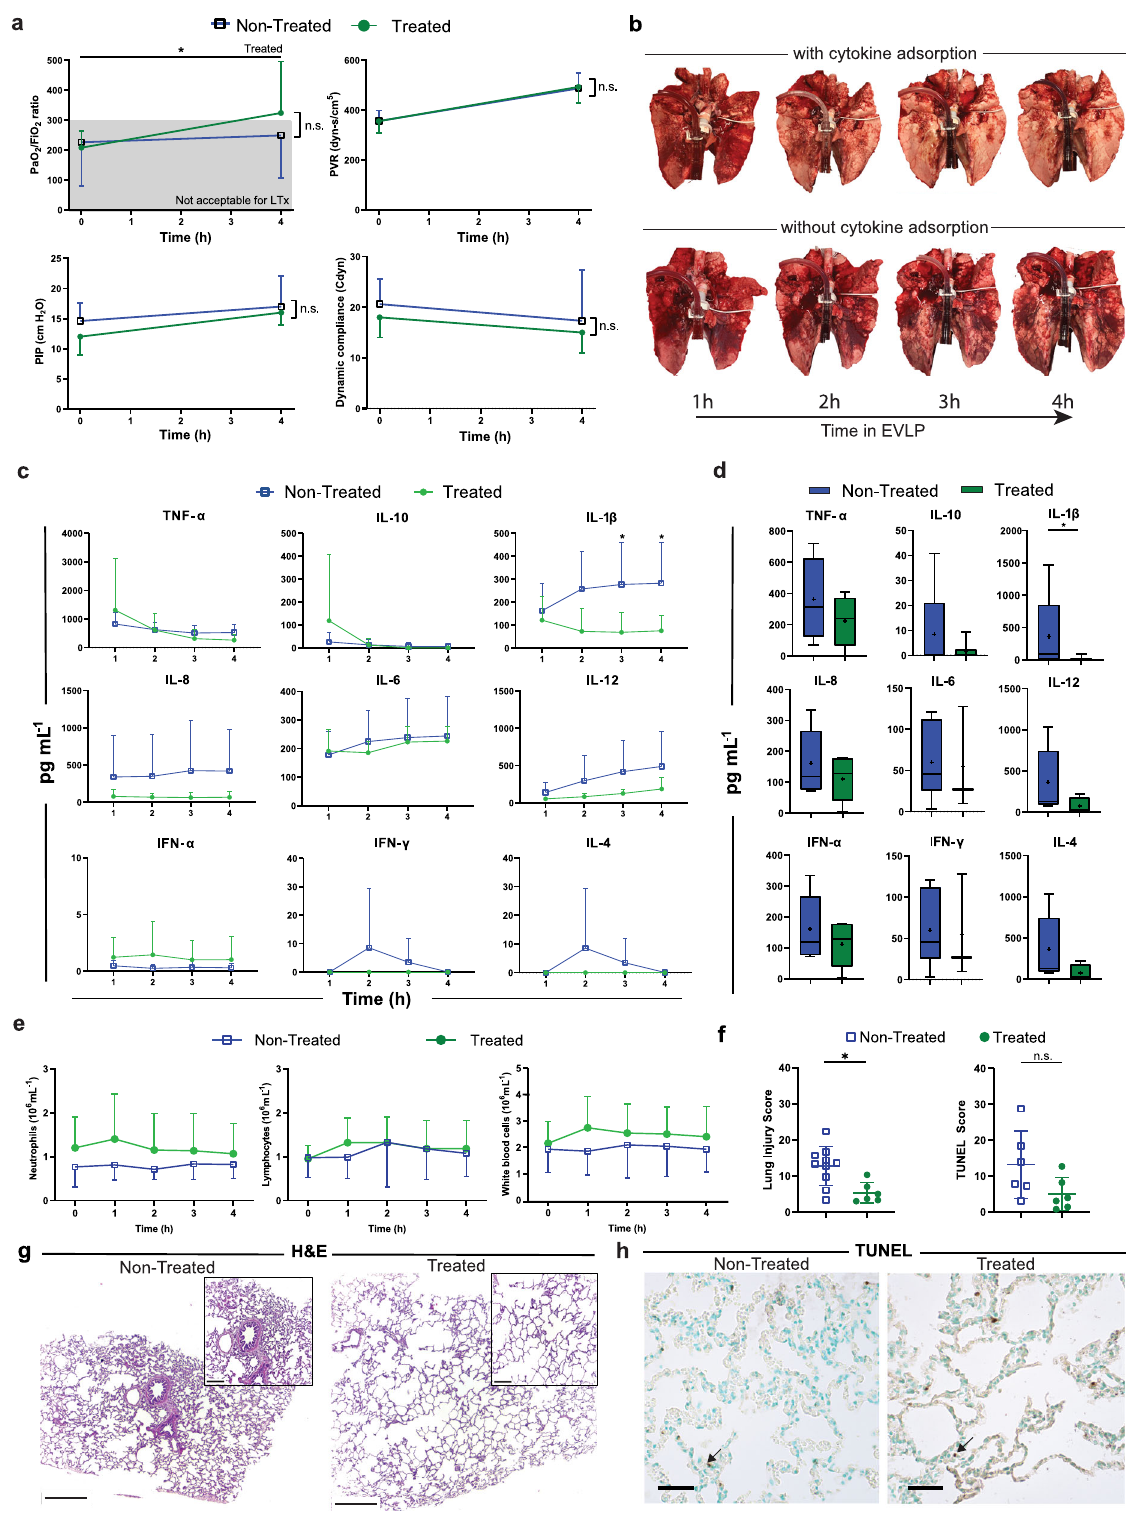
The lung tissue wet/dry weight ratios were measured after 4 hours of EVLP, and 48 hours post-transplantation in the two- step treatment and non-treatment group. While the ratios between the treated and non-treated group were not